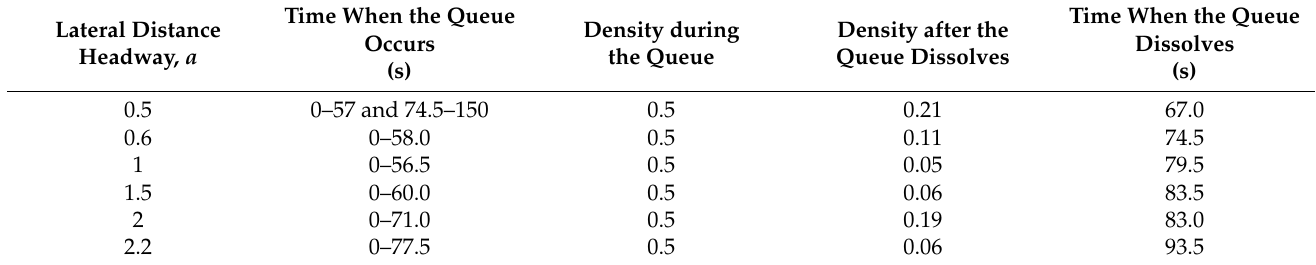
Table 10. Density and time for the proposed model during and after the queue